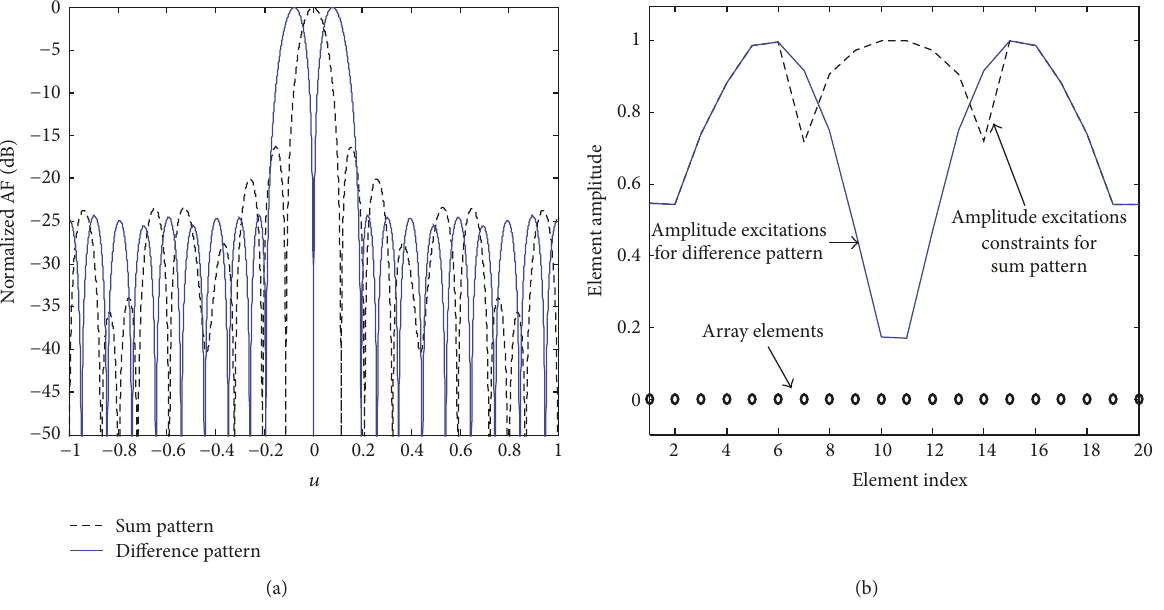
Figure2:Sumanddifferencepatterns(a)andthecorrespondingamplitudeexcitation(b)forthecaseoffixeddifferencepattern,60%common excitation, and 𝑁 = 20 elements.